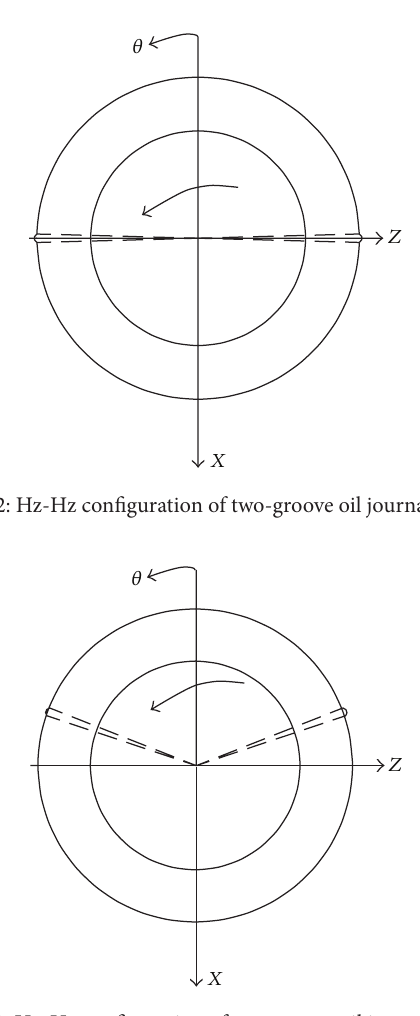
Figure 3: Up-Up configuration of two-groove oil journal